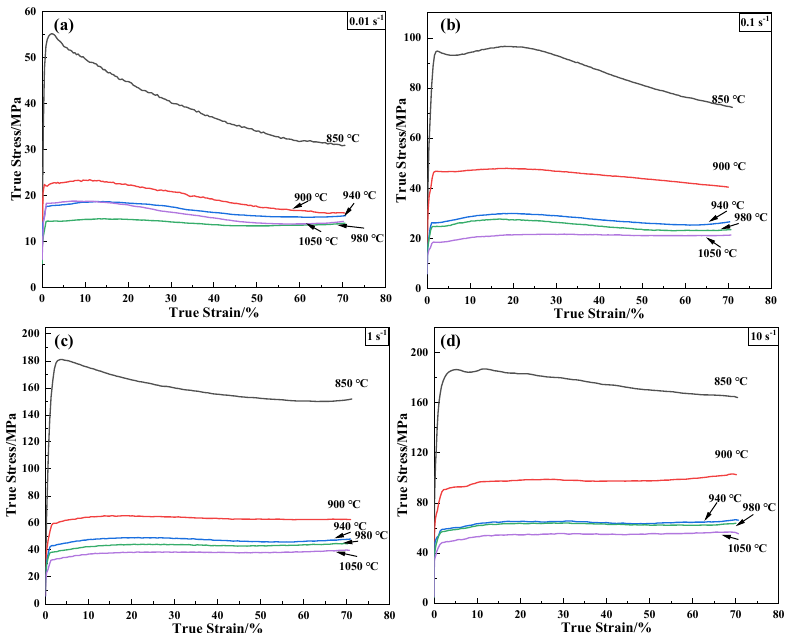
Figure 3. True stress–strain curves of annealed TA31 alloy under different strain rates: ( a ) 0.01 s − 1 ; ( b ) 0.1 s − 1 ; ( c ) 1 s − 1 ; and ( d ) 10 s − 1 .